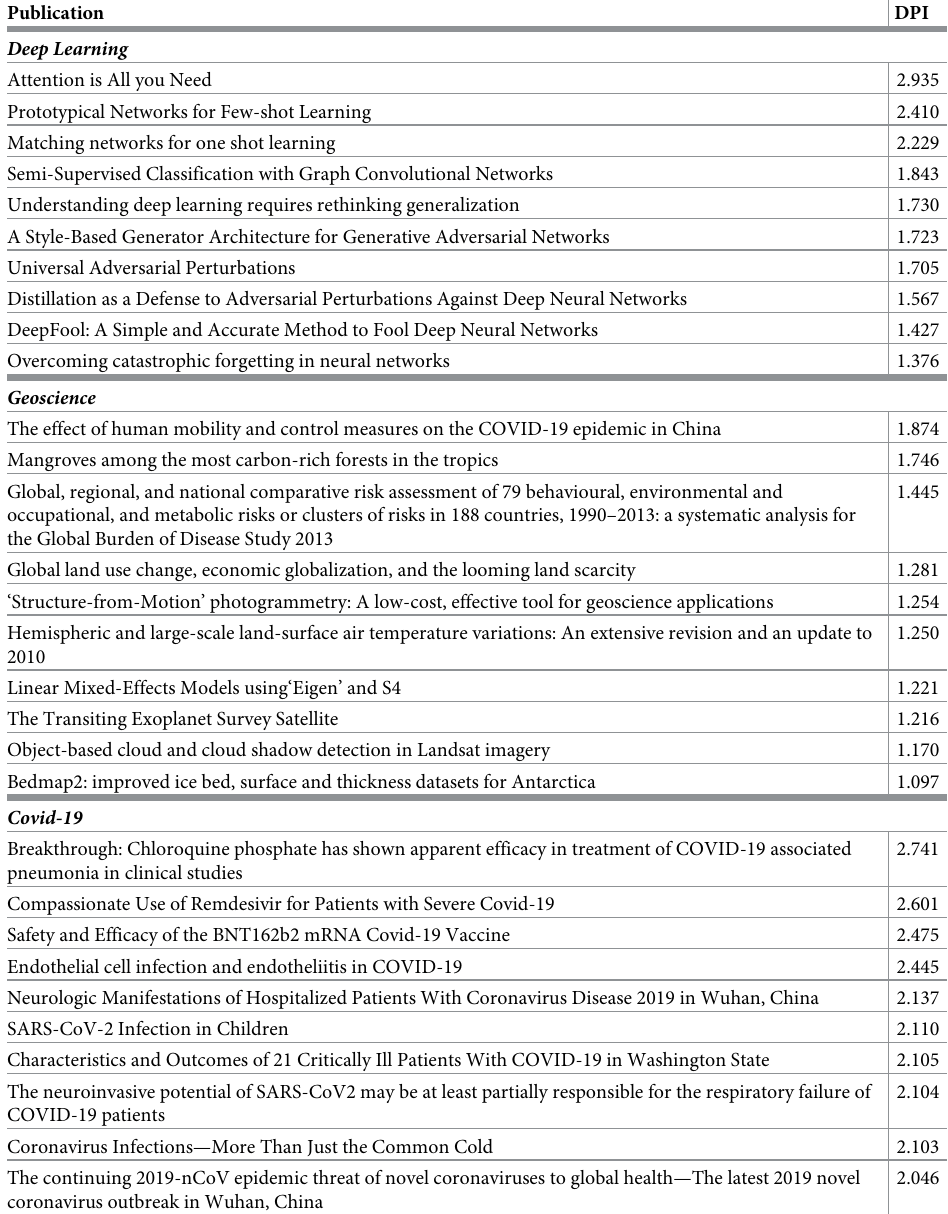
Table 3. Top ten development potential publications in the field of deep learning, geoscience and Covid-19.